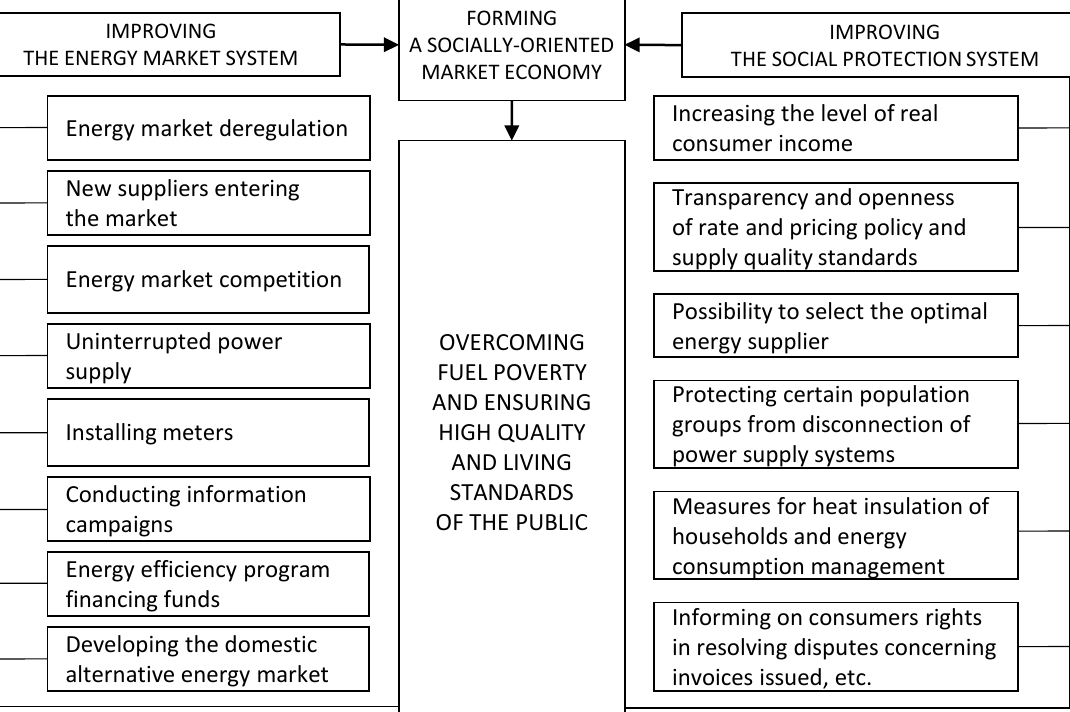
Figure 4. System for overcoming “fuel poverty” in the aspect of constructing a socially-oriented market economy in